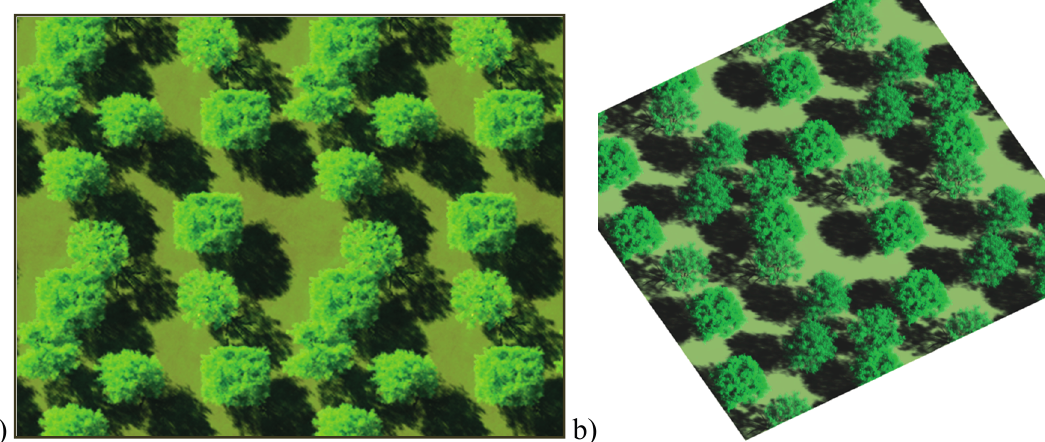
Figure 8. DART simulated RGB composite of satellite image in natural colors for a virtual tree formation displayed in: ( a ) nadir, and ( b ) oblique